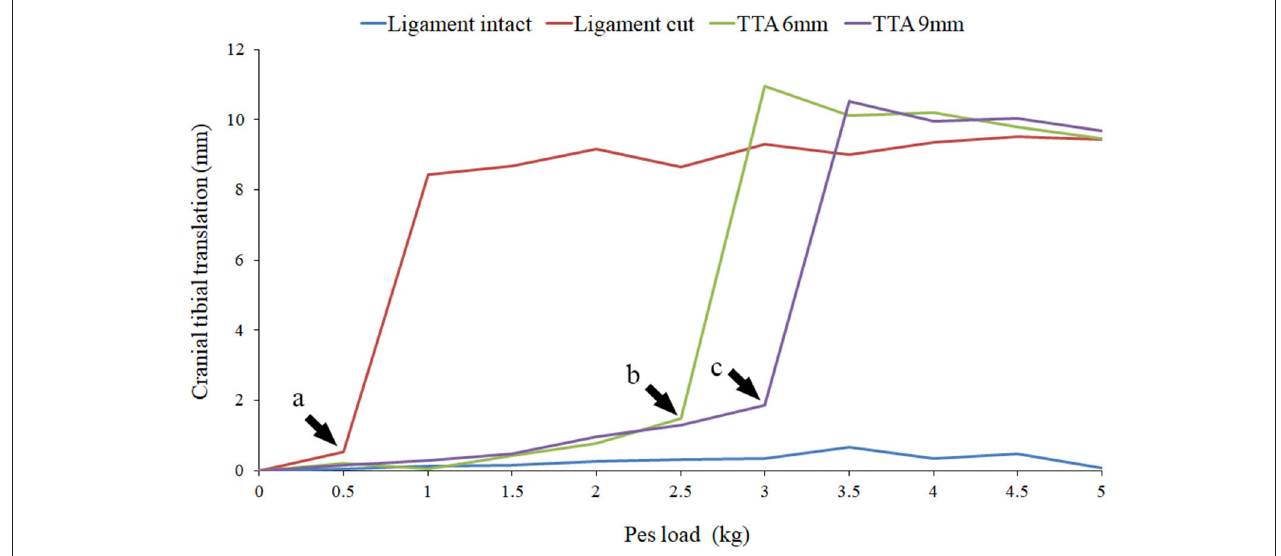
FIGURE 3 | The results of Specimen 5 with the stifle joint at 120 ◦ of flexion and a quadriceps load of 5kg are illustrated in this graph. Results with the cruciate ligament intact (light blue), cut (dark red), TTA 6mm (light green) and TTA 9mm (dark green) at all the pes loads are represented. The loads prior to failure are marked by the arrow heads. At pes loads exceeding the point of failure a marked increase in cranial translation of the tibia was